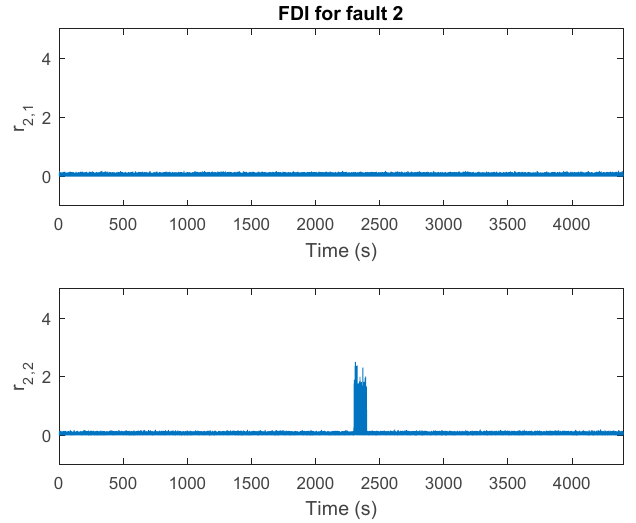
Figure 6. Fault bias in the second pitch during the time 2300 to 2400 s.